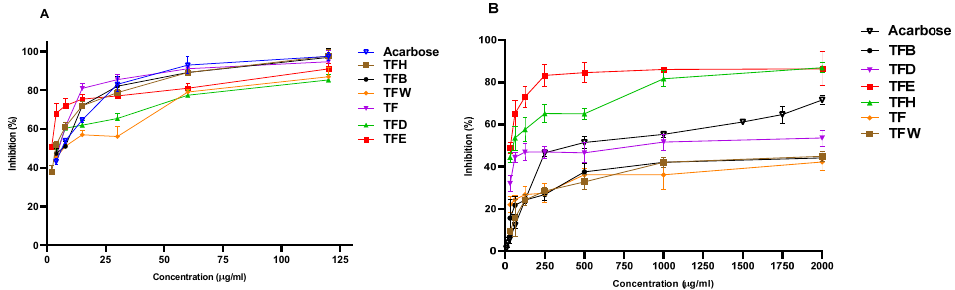
Figure 1. α -Glucosidase ( A ) and α -amylase ( B ) inhibitory activities of R. iconiensis flower extracts and sub-extracts.